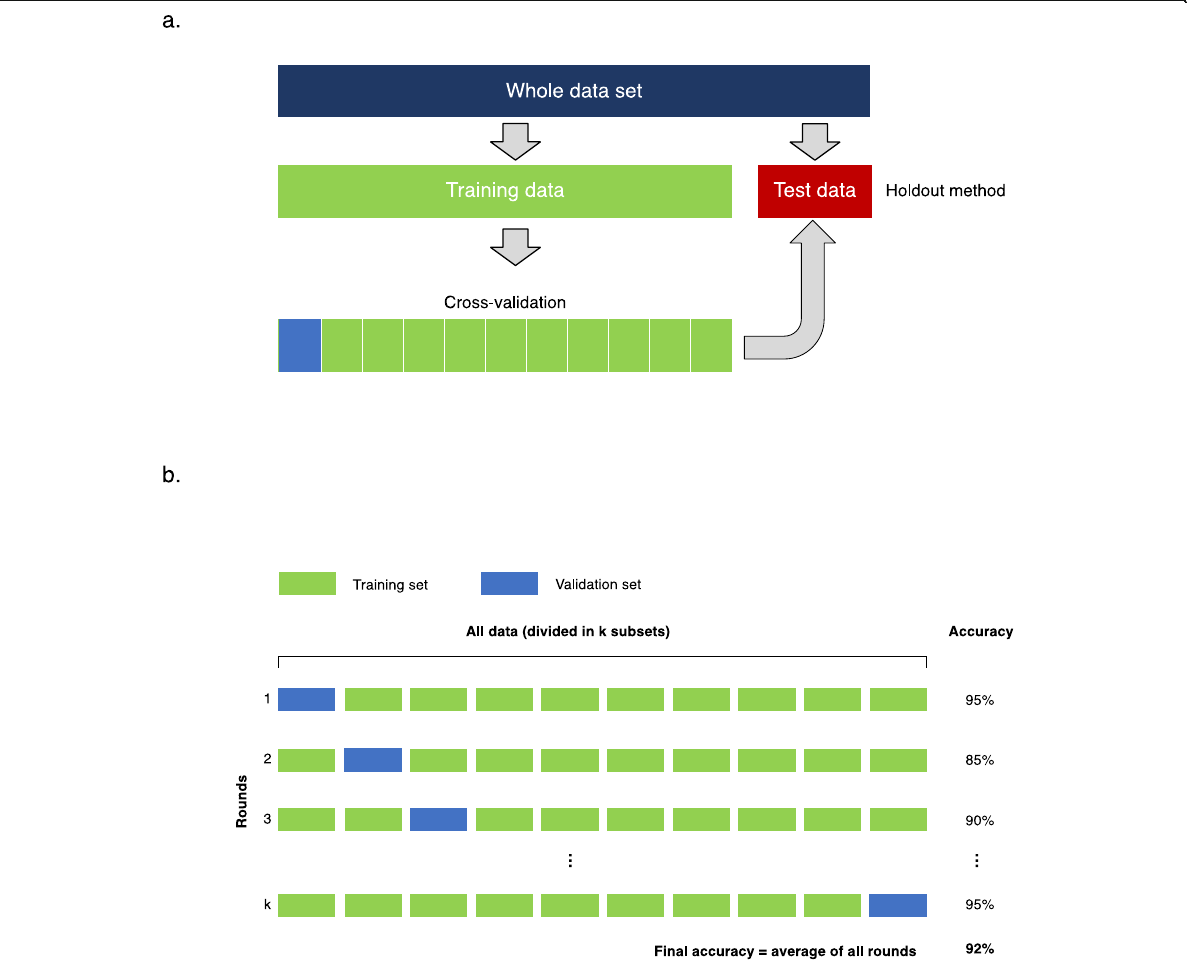
Fig. 7 Data sampling strategies. a The whole dataset is split in two distinct subsets for training and testing purposes. Training dataset is subdivided to perform cross-validation, ( b ) k-fold cross-validation. The training dataset is divided in k subsets of equal size. Training is performed sequentially, considering at each iteration a specific subset as validation set